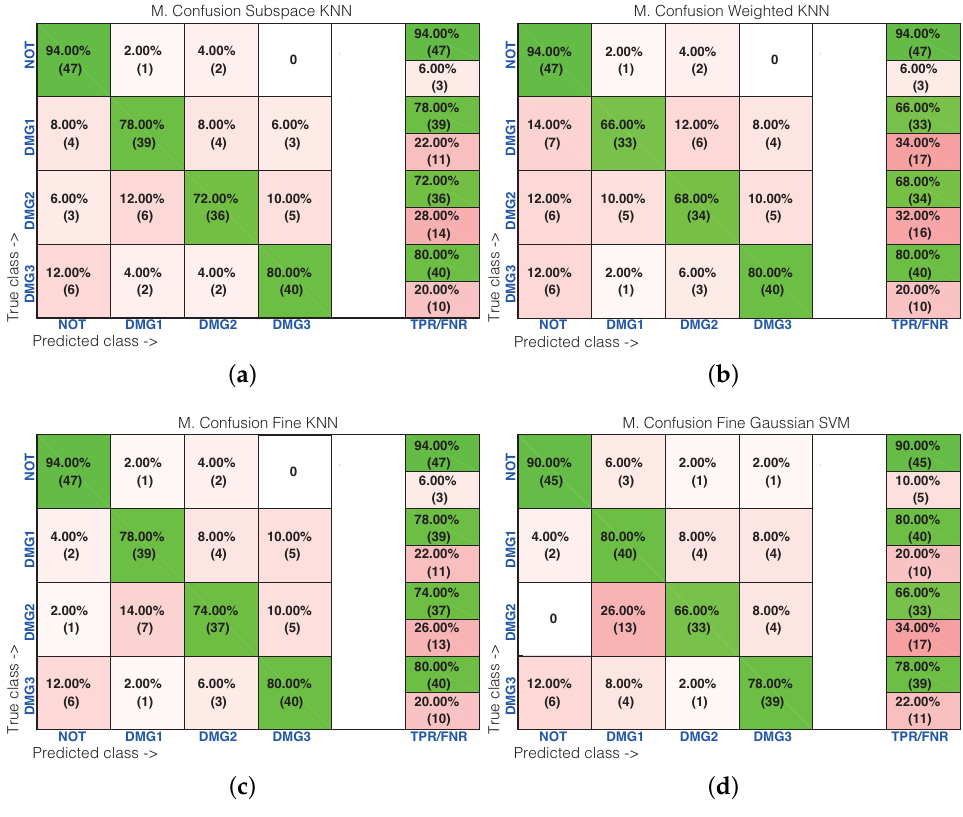
Figure 16. Confusion matrix using: ( a ) subspace k -NN; ( b ) weighted k -NN; ( c ) fine k -NN; and ( d ) fine Gaussian SVM. Table 1. Percentage of correct decisions for the healthy structure and the structure with Damage 1, 2 and 3, for the twenty different machine learning strategies (aluminum